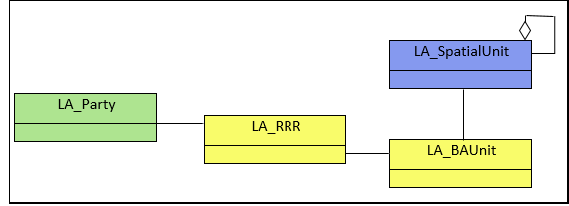
Figure 2. Basic Classes of